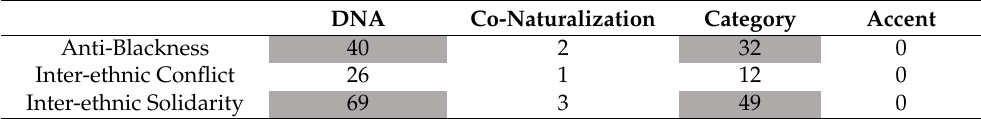
Table 7. Conflict and solidarity by raciolinguistic